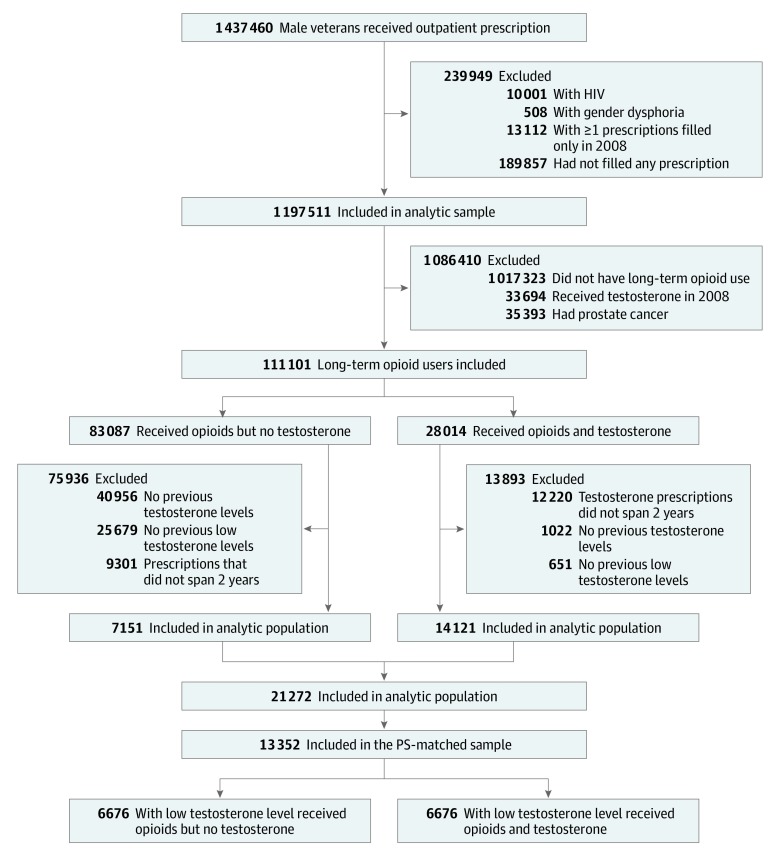
STROBE Diagram of Analytical Sample Selection Long-term opioid use was defined as use by patients who received 120 or more days’ supply of opioids during at least 1 continuous 180-day interval in 2 or more years. Low testosterone level was defined as total testosterone level of less than 300 ng/dL (to convert to nanomoles per liter, multiply by 0.0347) or free testosterone level of less than 70 pg/mL in the past 1 year. PS indicates propensity score.